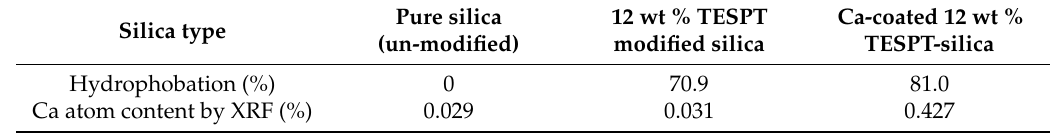
Table 9. Hydrophobation and calcium content according to the type of modified